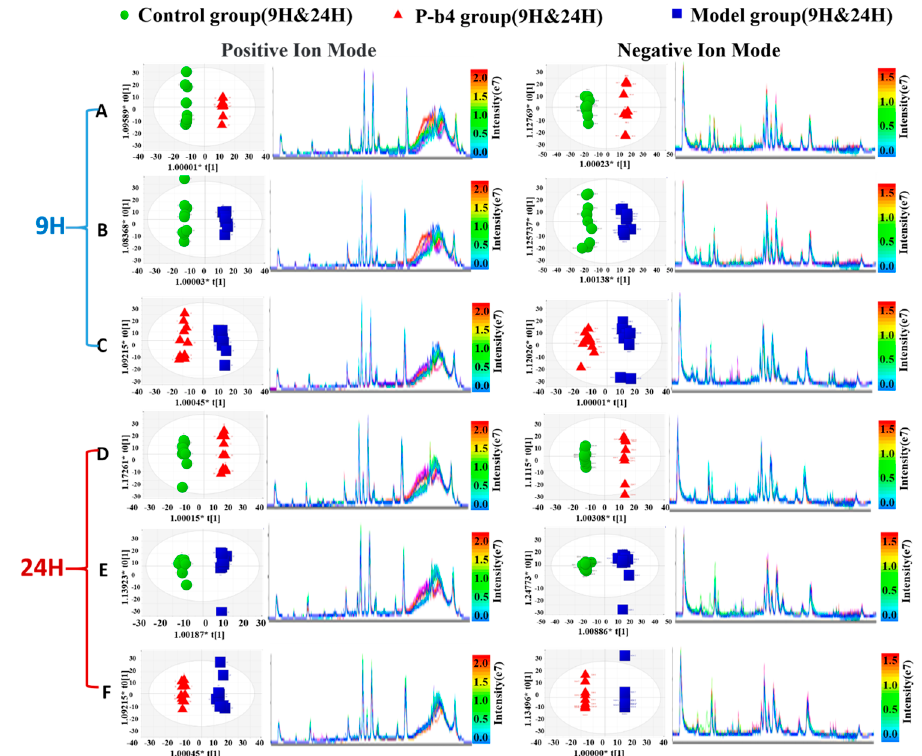
Figure 4. Orthogonal partial least squares-discriminant analysis score plots of samples (left panel) and TICs (right panel) obtained from di ff erent groups: ( A ) C-9 (green dots) VS P-9 (red dots); ( B ) C-9 (green dots) VS M-9 (bule dots); ( C ) P-9 (red dots) VS M-9 (bule dots); ( D ) C-24 (green dots) VS P-24 (red dots); ( E ) C-24 (green dots) VS M-24 (bule dots); ( F ) P-24 (red dots) VS M-24 (bule dots). The color bar on the right corresponds to the intensity of samples, beginning from weak (blue) to strong